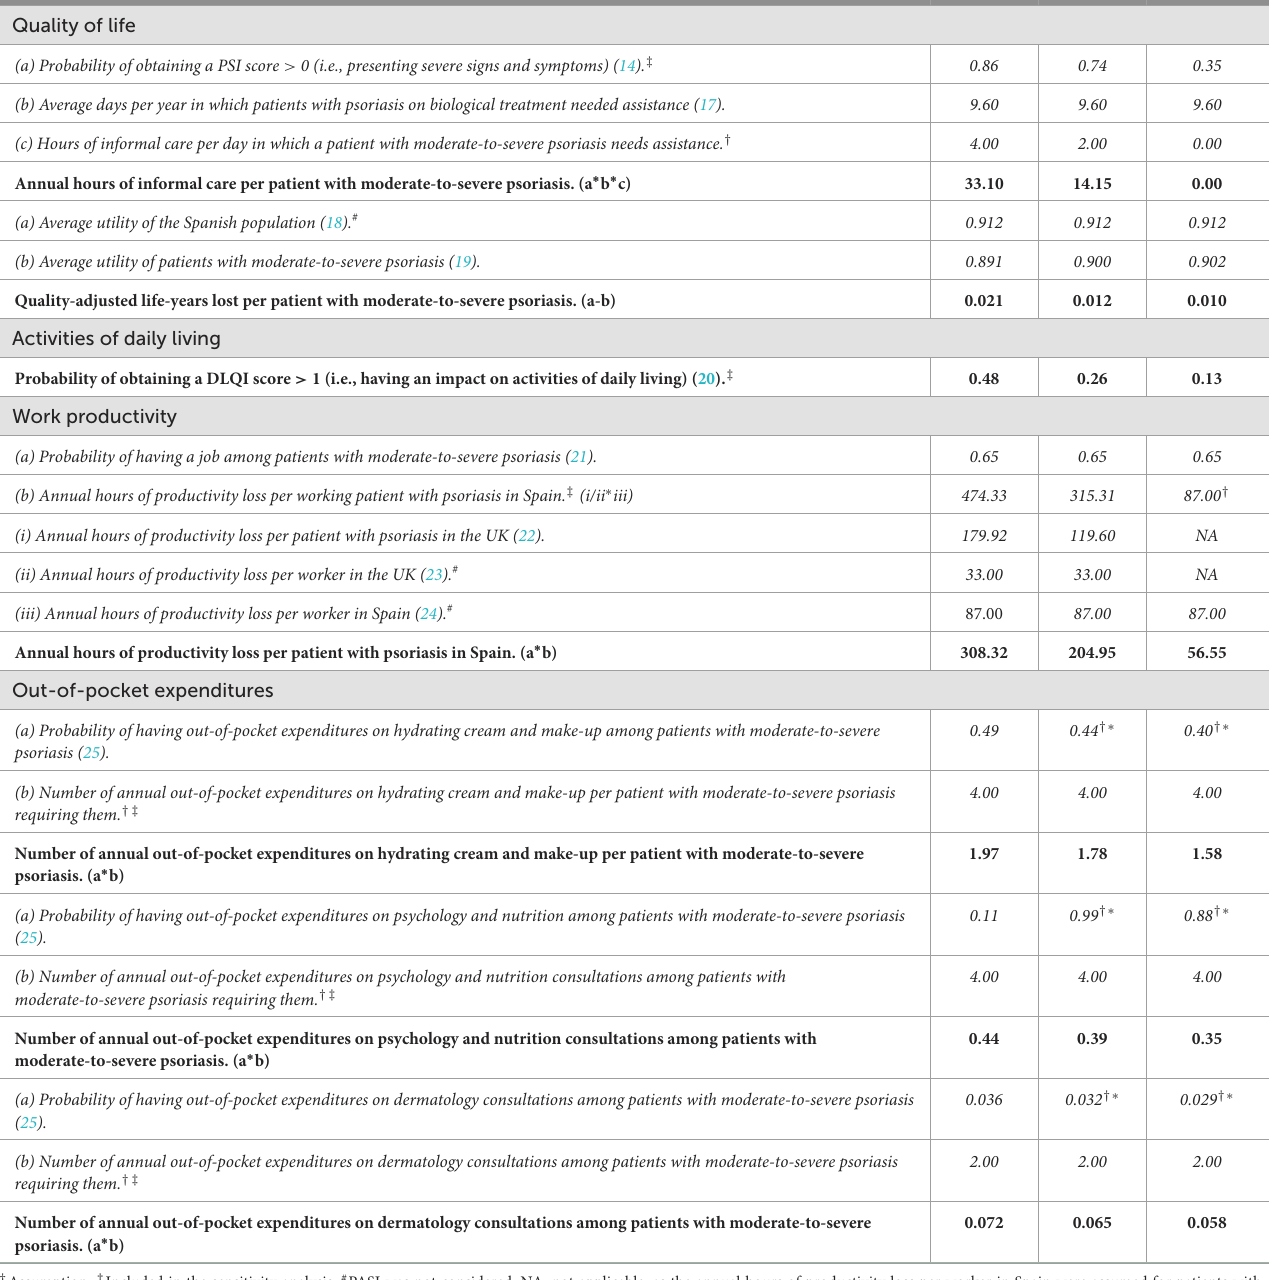
TABLE 1 Outcomes by areas of analysis and PASI responses.